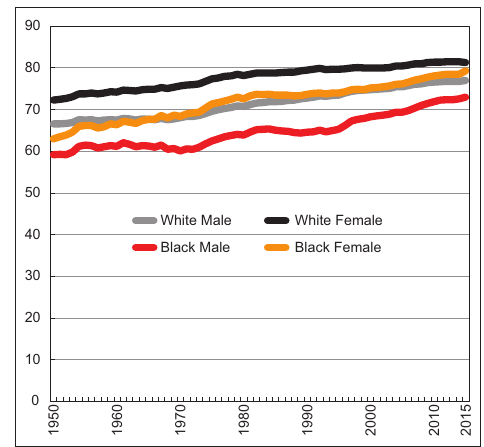
Fig ure 6. Life Expectancy at Birth (in Years) by Race and Sex, United States, 1950-2015 Source: CDC/NCHS. National Vital Statistics